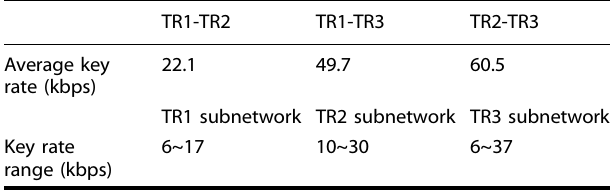
Table 2. List of the average key rates between subnetworks and the key rate ranges with in the three subnetworks